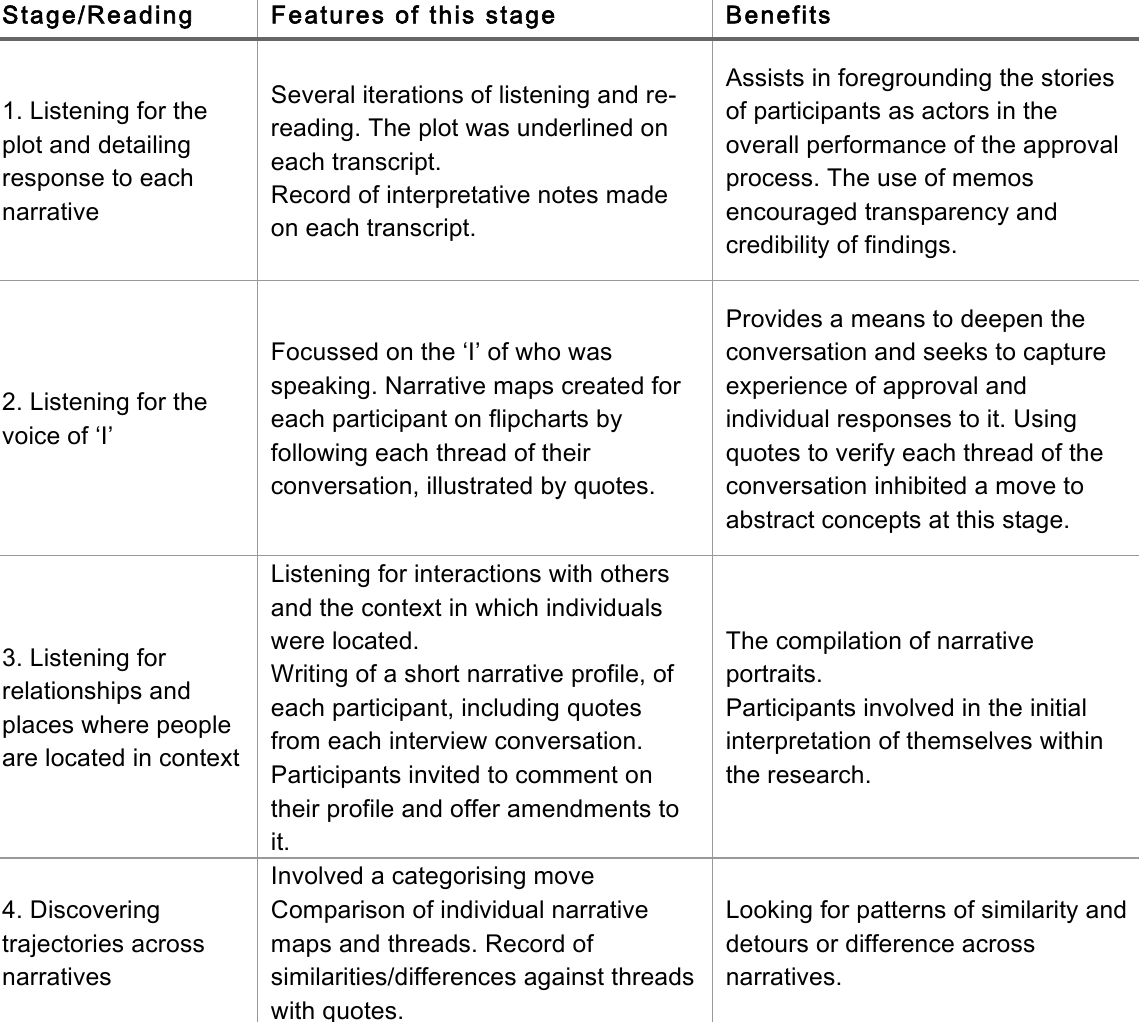
Table 3: Interpretative montage: Illustrating different stages of interpretative